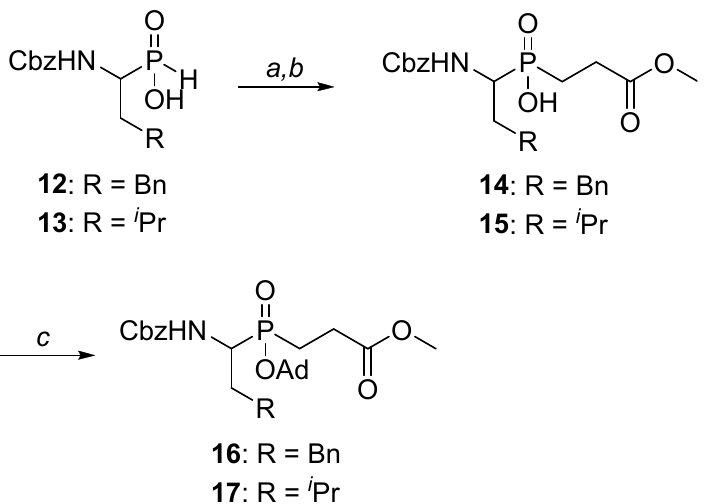
Scheme 2. Synthesis of the key building blocks 16 and 17 bearing the side chains of pseudo-HPhe and -Leu, respectively, and required for preparing the target phosphinopeptides 1 – 9 . Reagents